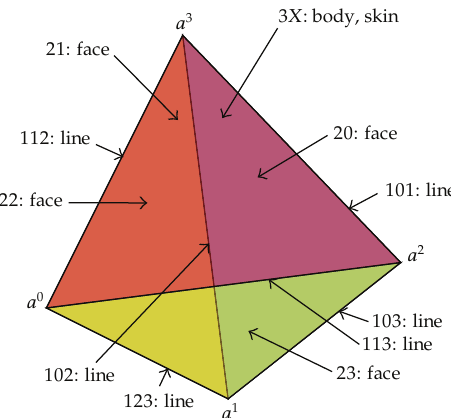
Figure 4: A simplex membrane structure.